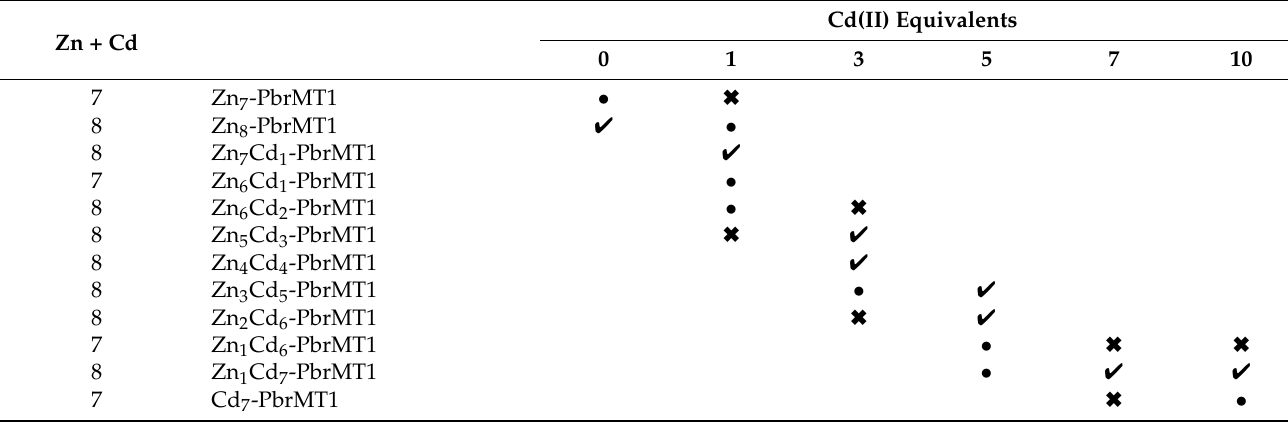
Table 2. Species detected by ESI-MS during the addition of Cd(II) to the Zn-PbrMT1 preparation at pH 7.0. The corre- sponding ESI-MS spectra are shown in Figure S2.